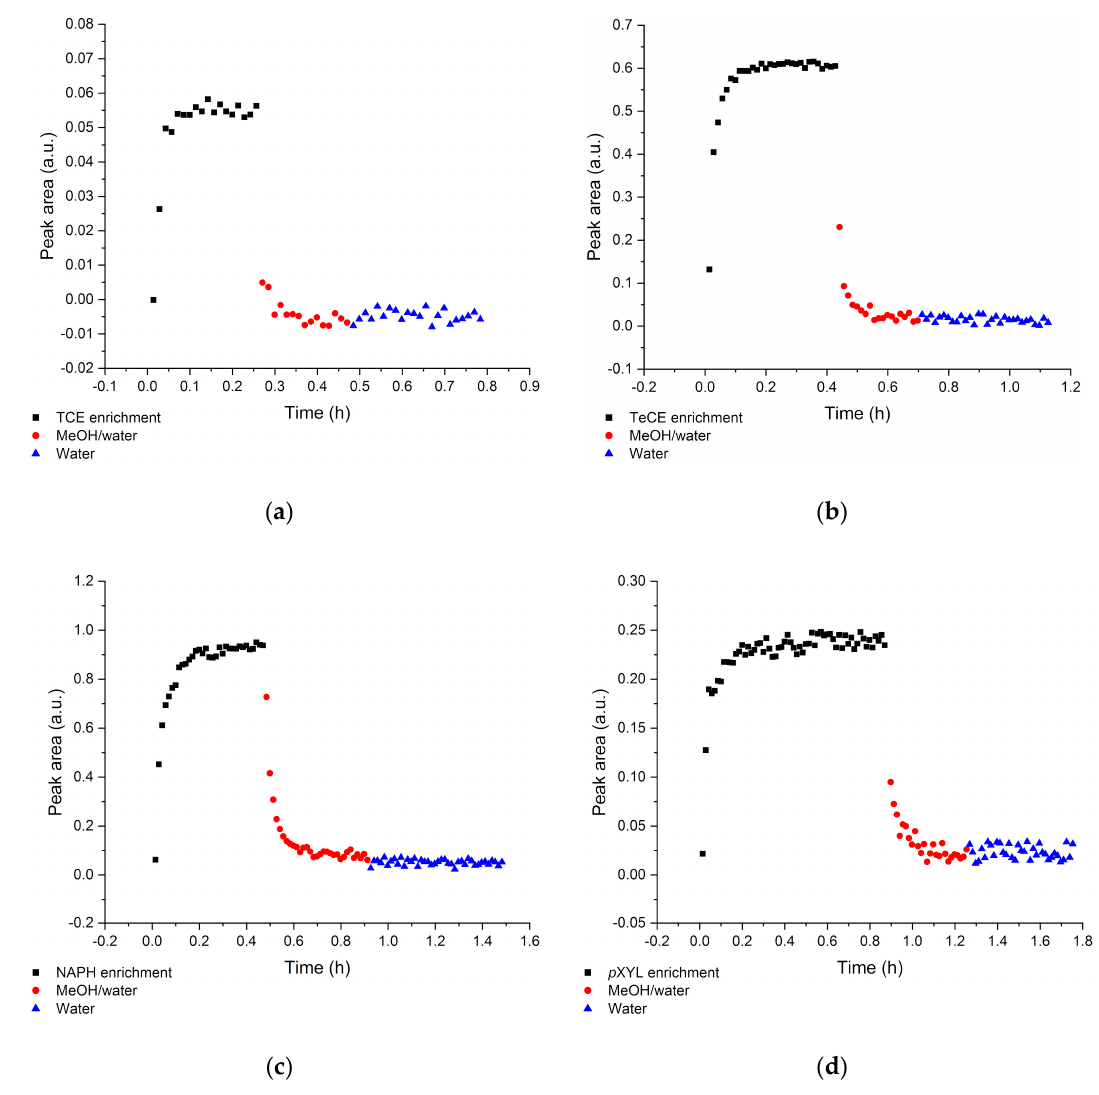
Figure 7. Entire measurement cycle exemplarily shown for ( a ) TCE (15 ppm), ( b ) TeCE (15 ppm), ( c ) ( c ) NAPH (25 ppm), and ( d ) p XYL (25 ppm). Black: enrichment of analyte into E / P-co polymer layer, NAPH (25 ppm), and ( d ) p XYL (25 ppm). Black: enrichment of analyte into E/P-co polymer layer, red: red: regeneration of polymer membrane using MeOH / water, and blue: flushing with water to remove regeneration of polymer membrane using MeOH/water, and blue: flushing with water to remove residual residual MeOH.